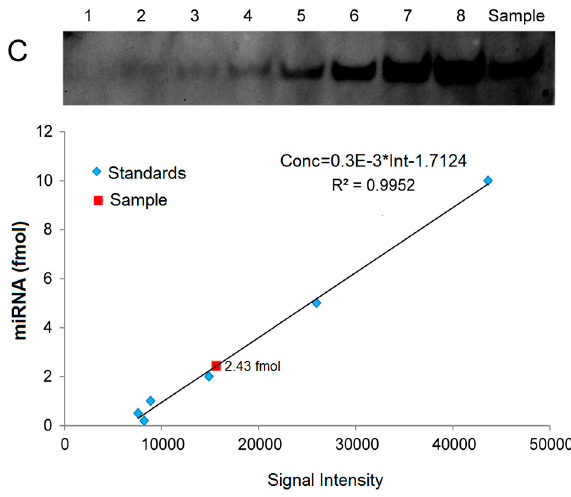
Figure 6. Quantitative analysis of miRNAs by LHSPD. ( A ) Quantitative analysis of Osa-miR156 in Oryza sativa seedlings by LHSPD with the biotin-luminol system. Upper : Image of Osa-miR156 from Oryza sativa seedlings; lanes 1–6 represent 0.8, 1.9, 3.9, 7.8, 15.6, and 31.2 fmol ( Biotin ) -miD156rk , respectively, hybridized with an excess of Osa-miR156 to create a standard curve; lane Sample is 1 µ g Oryza sativa small RNA sample hybridized with 0.1 pmol ( Biotin ) -miD156rk ; Lower : Image is a quantification using a Bio-Rad (Irvine, CA, USA) gel imaging system; ( B ) Quantitative analysis of let-7 in Mus musculus liver by LHSPD with the DIG-CDP Star system. Upper : Image of let-7 from Mus musculus liver; lanes 1–8 represent 0.25, 0.5, 1, 2.5, 5, 10, 25, and 50 fmol ( DIG ) -let-7rk , respectively, hybridized with an excess of let-7a to create a standard curve; lane Sample is 10 µ g of Mus musculus small RNA sample hybridized with 0.1 pmol ( DIG ) -let-7rk ; Lower : Image is a quantification using a Bio-Rad gel imaging system; ( C ) Quantitative analysis of let-7 in Drosophila melanogaster by LHSPD with the biotin-CDP Star system. Upper : Image of let-7 from Drosophila melanogaster ; lanes 1–8 represent 0.05, 0.1, 0.2, 0.5, 1, 2, 5, and 10 fmol ( Biotin ) -let-7rk , respectively, hybridized with an excess of let-7a to create a standard curve; lane Sample is 10 µ g of Drosophila melanogaster small RNA sample hybridized with 0.1 pmol ( Biotin ) -let-7rk ; Lower : Image is a quantification using a Bio-Rad gel imaging system.